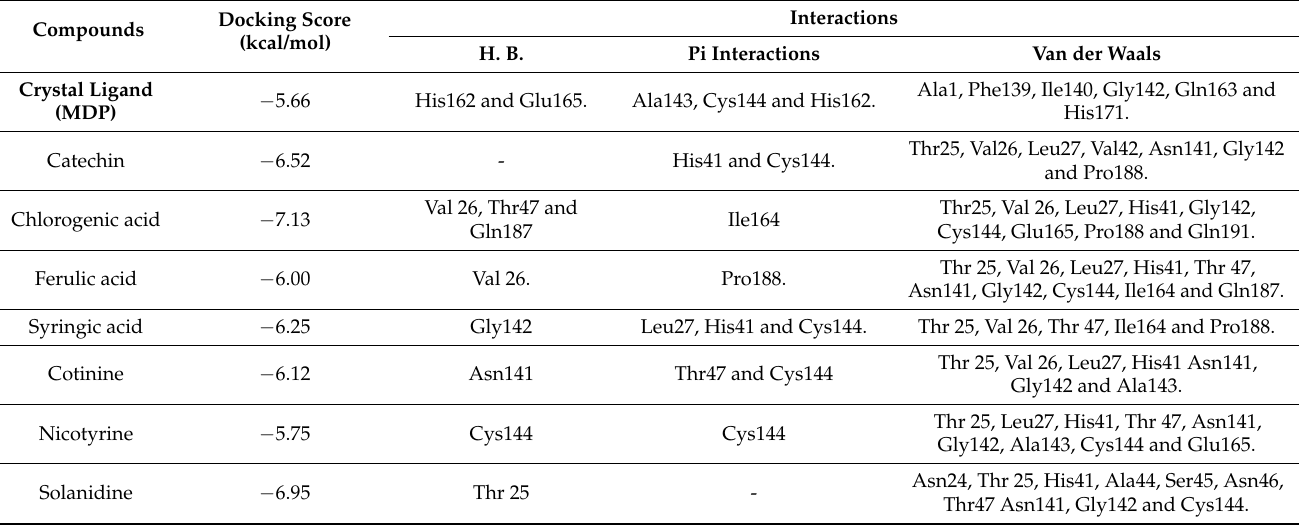
Table 5. (DG, interactions) kcal/mol of (natural tested ligands) against the target site of (HCo-V 229E main protease).